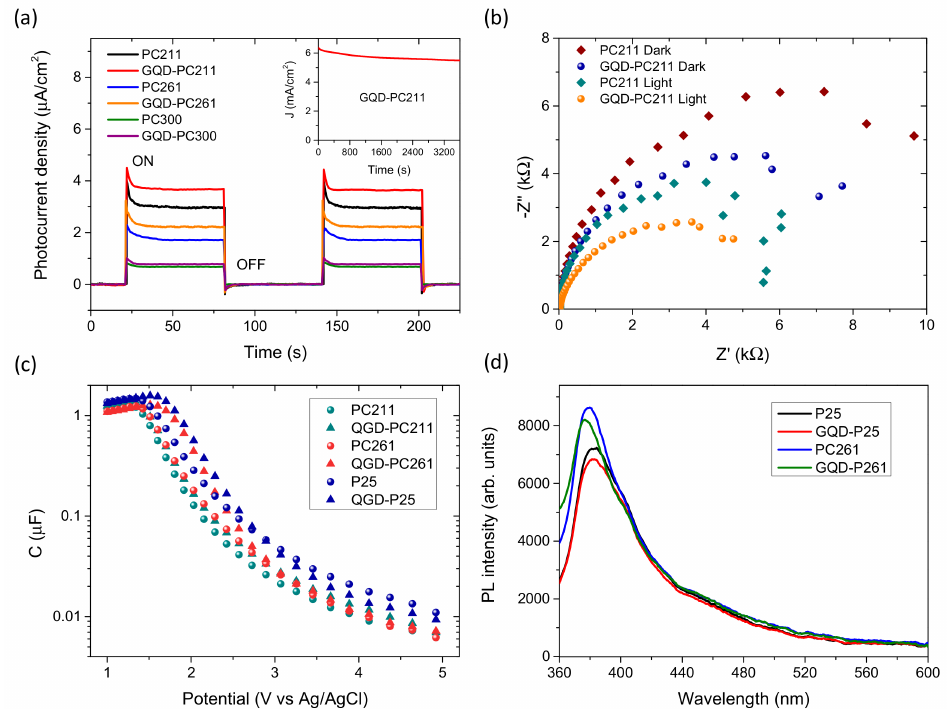
Figure 11. ( a ) Transient photocurrent density for pristine and surface-modified GQD-PC films under UV–VIS illumination; ( b ) EIS Nyquist plots for the PC211 and GQD-PC211 films under dark and UV–VIS illumination; ( c ) capacitance vs. applied potential for pristine and GQDs-modified PC and P25 films at 1000 Hz; ( d ) PL spectra for P25 and PC211 before and after GQDs surface modification. The inset in ( a ) shows the variation of photocurrent density (J) for GQD-PC211 films under continuous UV–VIS irradiation for 1 h at 1.23 V Ag /